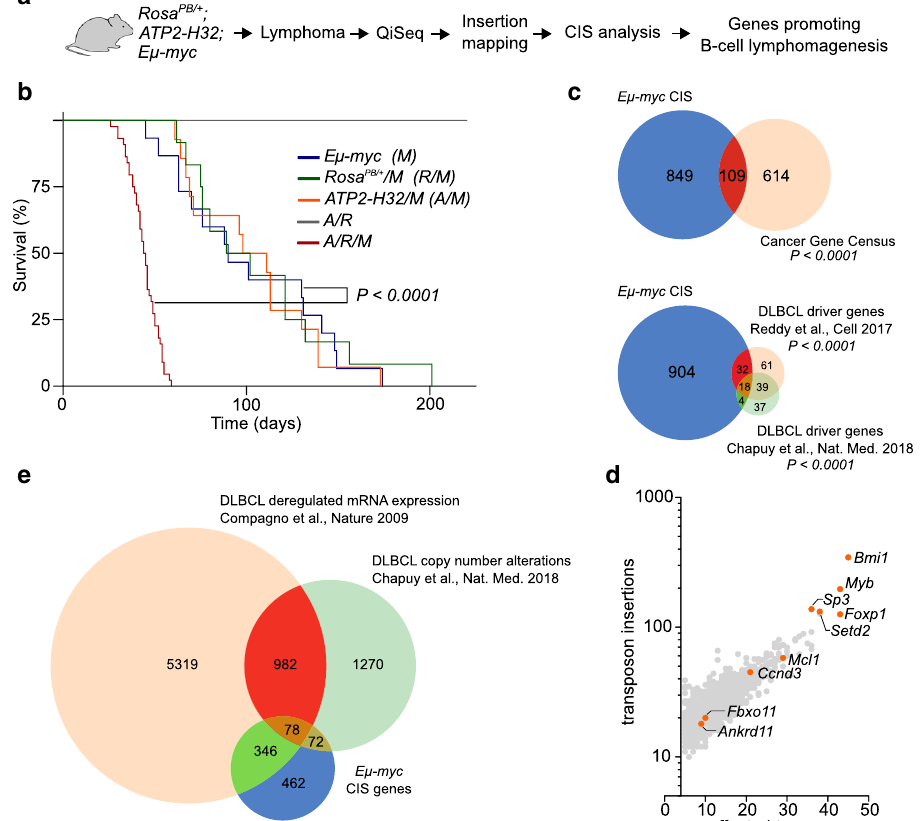
Fig. 1 Transposon mutagenesis promotes B-cell lymphomagenesis. a Outline of experimental setup for the identi fi cation of genetic alterations that promote MYC-mediated B-cell lymphomagenesis. b Kaplan – Meier survival curves of the indicated cohorts of mice. In total 90 mice were aged up to 220 days to investigate the effects of piggyBac transposon mutagenesis on lymphomagenesis on an MYC-activated background. E µ -myc (M), n = 15; Rosa PB/ + /M (R/M), n = 12; ATP2-H32/M (A/M), n = 14; A/R, n = 5; A/R/M, n = 44. The mean survival times (days) were 44.5 for the A/R/M cohort and 90 for the M cohort. P < 0.0001. P -value determined by log-rank (Mantel – Cox) test. c Venn diagram showing the overlap between common insertion sites (CISs) in A/R/M lymphomas and genes listed in the Cancer Gene Census or B cell lymphoma (DLBCL) driver genes described in refs. 9,10 . P -value determined by Fisher ’ s exact test. d Graph showing the number of transposon insertions per CIS against the number of affected tumors. Every dot represents one CIS. The information on the number of transposon insertions and the number of affected tumors are provided in Supplementary Data 1. Selected examples listed in the Cancer Gene Census database are highlighted in orange. e Venn diagram showing the overlap between CIS genes derived from the E µ -myc transposon mutagenesis screen and genes with differential mRNA expression (FDR P -value < 0.05) in DLBCL samples when compared to healthy GC B-cells 21 , or genes affected by copy number alterations in DLBCL cases 10